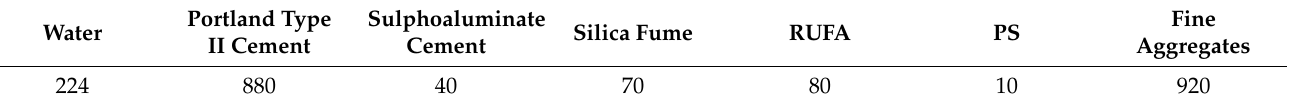
Table 2. The mix design of the commercial UHPG (kg/m 3